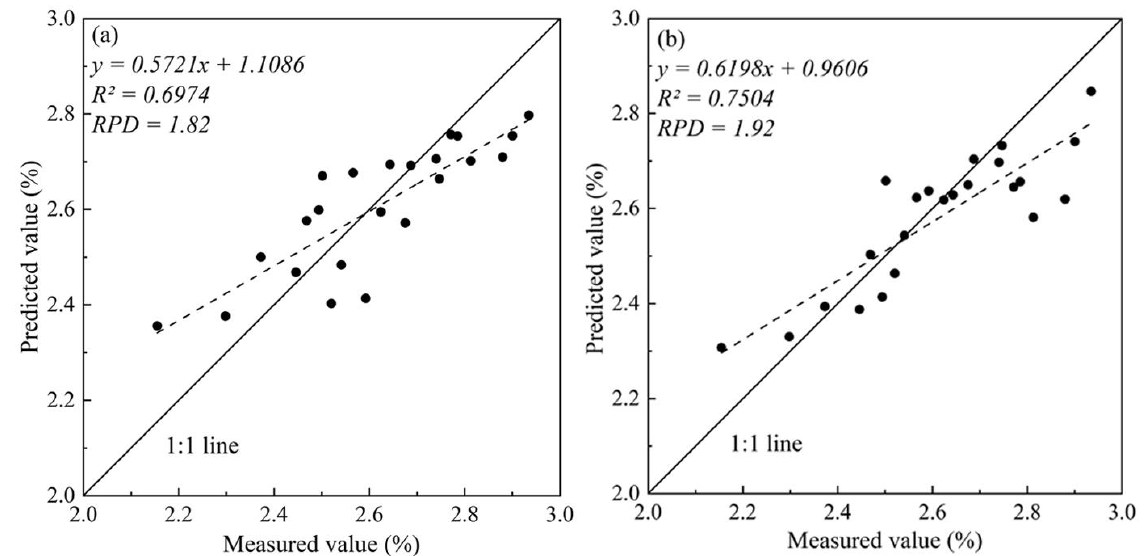
Figure 4. The relationship between CNC measured value and BPNN predicted value based on different variable combinations: ( a ) Random two-band spectral indices; ( b ) Combination of random two-band spectral indices and red-edge parameters.